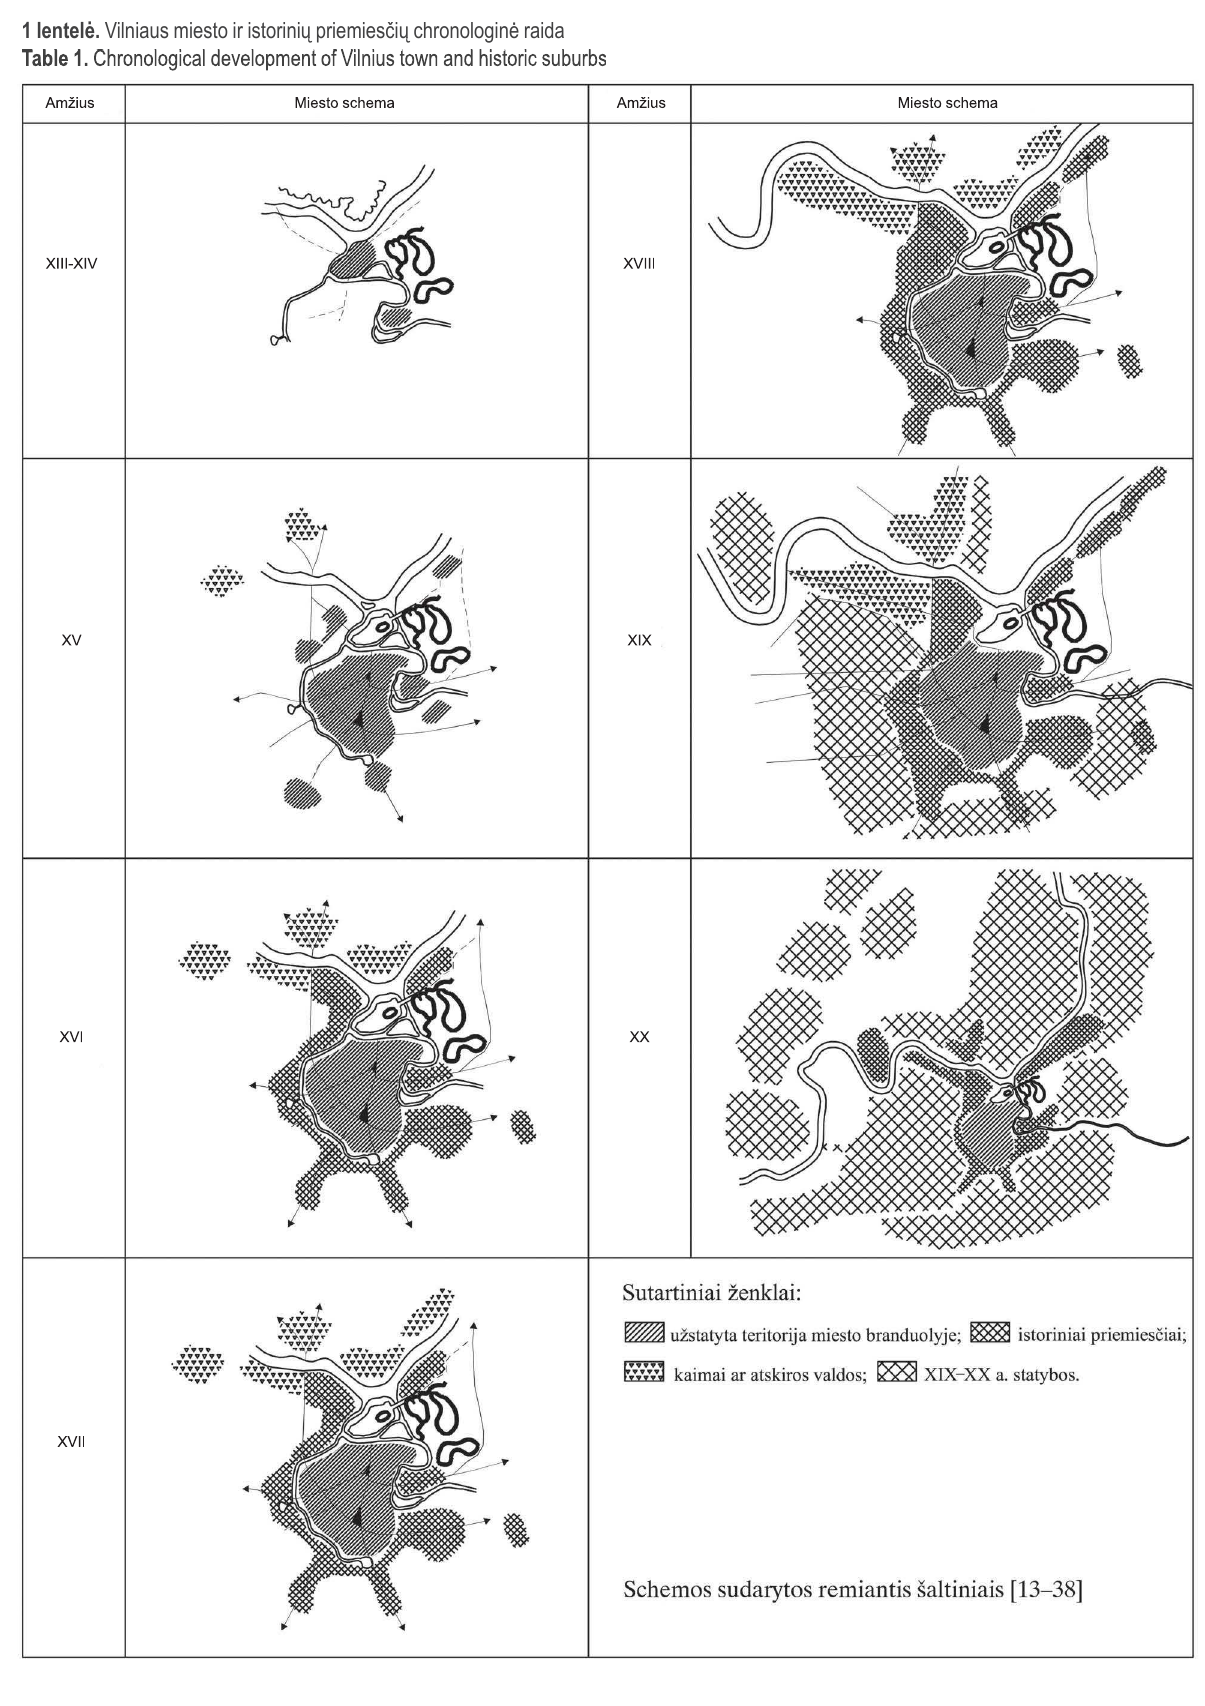
Table 1.Table 1. Chronological development of Vilnius town and historic suburbs Chronological development of Vilnius town and historic